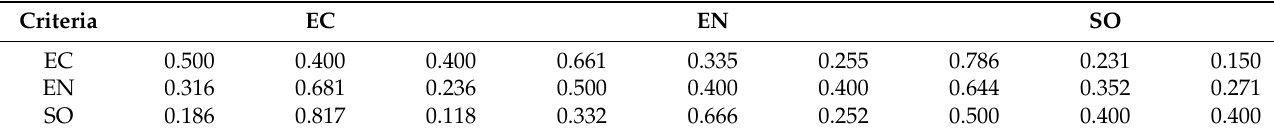
Table 11. Integrated spherical fuzzy matrix.